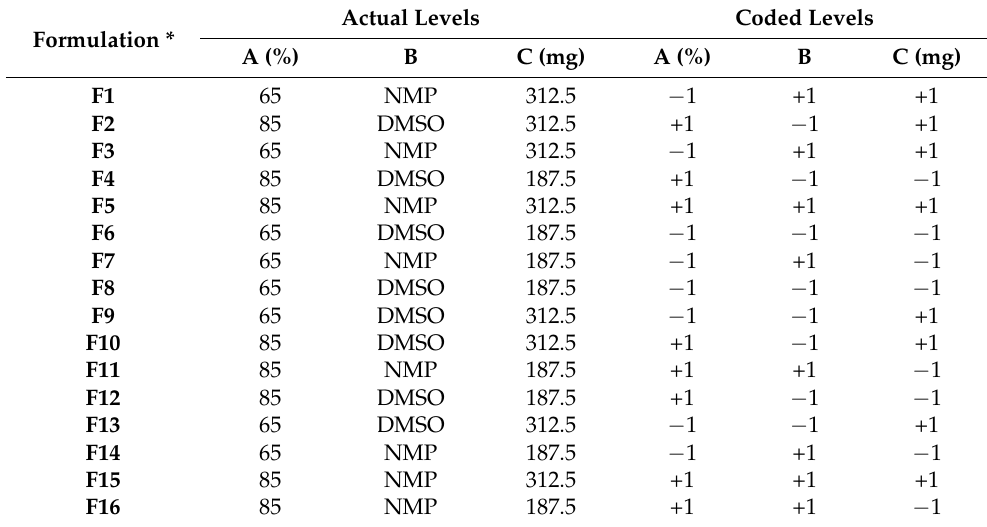
Table 2. Sixteen experimental runs as suggested by 2 3 factorial design. Formulation